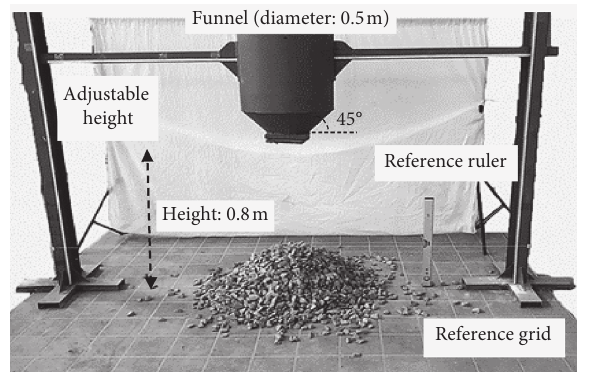
Figure 1: Large-scale hopper flow test equipment for